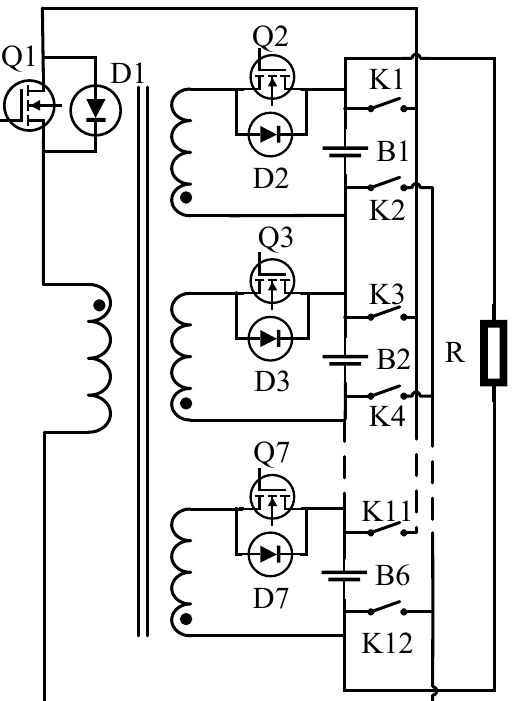
Figure 3. Balanced topology based on bidirectional flyback DC converter .